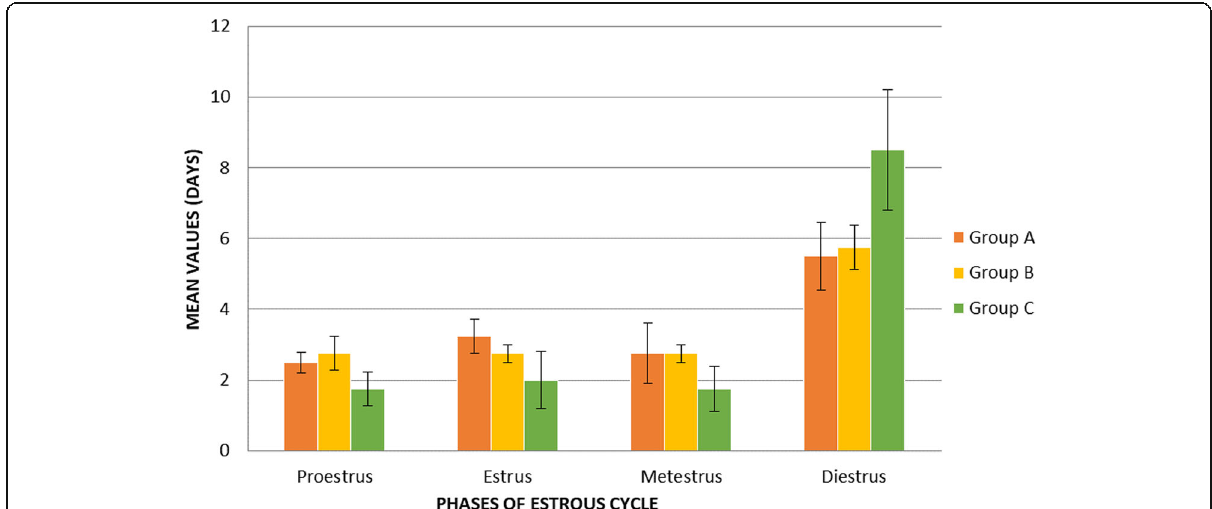
Fig. 1 Effect of perinatal β -cyp exposure on the estrous cycle of female F1 generation rats at sexual maturity. Results are given as mean ± SEM for 5 rats in each group. Experimental groups are compared with group A (control). No significant difference at a 95% confidence interval ( p > 0.05). Groups A, B, and C represent the control (given 0.5 ml olive oil), 15 mg/kg β -cyp-treated rats, and 30 mg/kg β -cyp-treated rats,